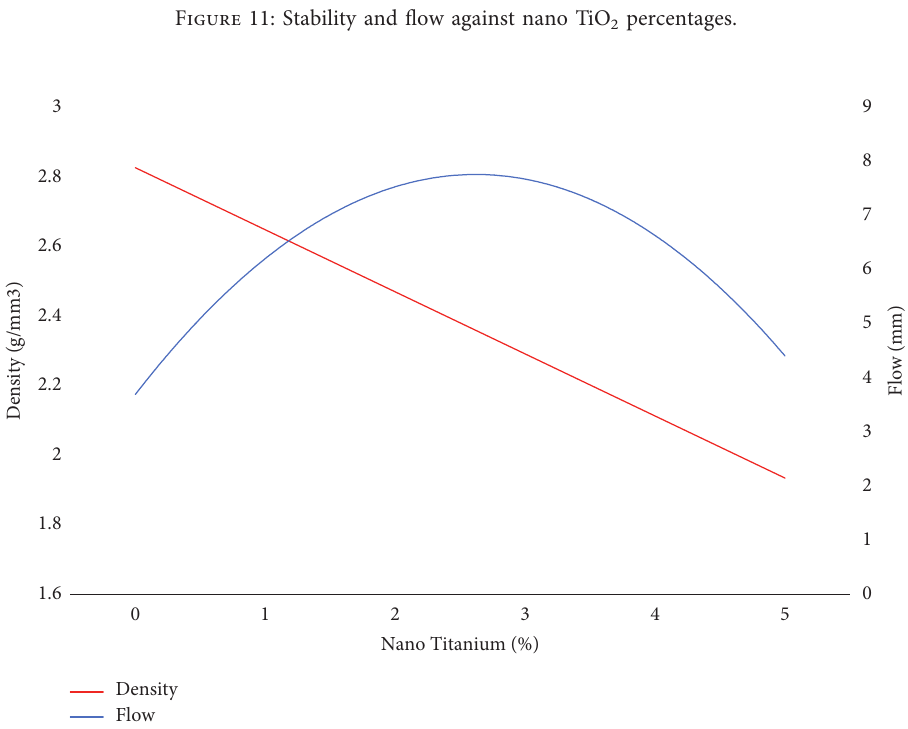
Figure 12: Density and flow against nano TiO